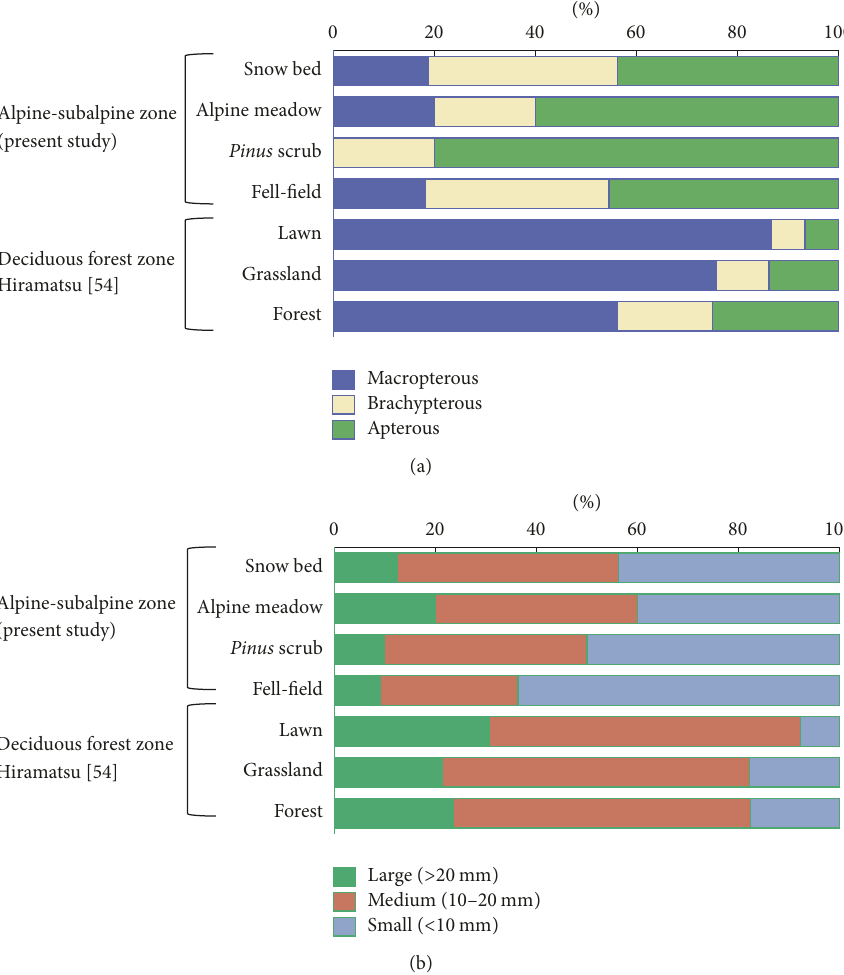
Figure 5: The percentage contributions of (a) small ( < 10mm), medium (10–20mm), and large ( > 20 mm) carabid beetles and (b) macropterous, apterous, and brachypterous wing forms in the four habitats of the alpine-subalpine zone (altitude 2070–2600 m) and three habitats in the deciduous forest zone (altitude 140–680 m) on Mt. Hakusan. The data for the deciduous forest zone are based on Hiramatsu